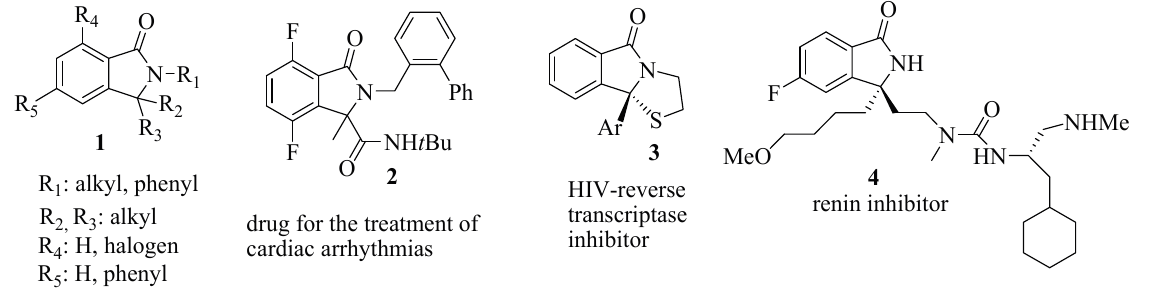
Figure 1. Examples of synthetic pharmacalogically active chiral 3,3-disubstituted isoindolinones.